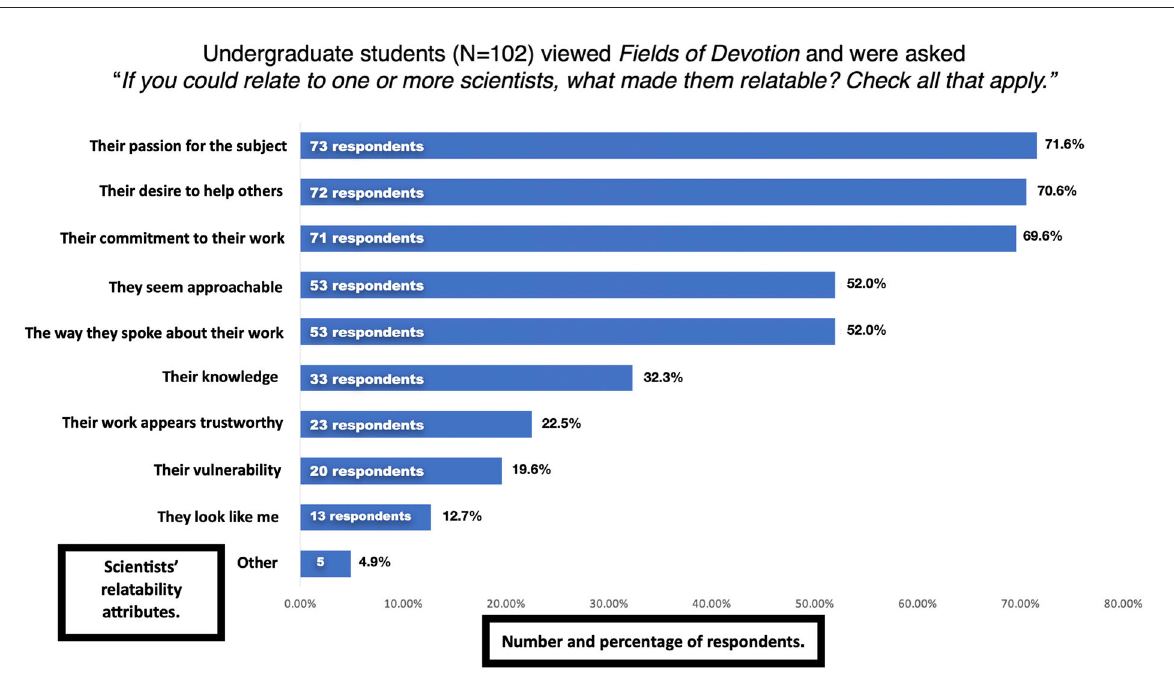
FIGURE11 Undergraduate students ( N = 102) viewed Fields of Devotion and were asked “If you could relate to one or more scientists, what made them relatable? Check all that apply”